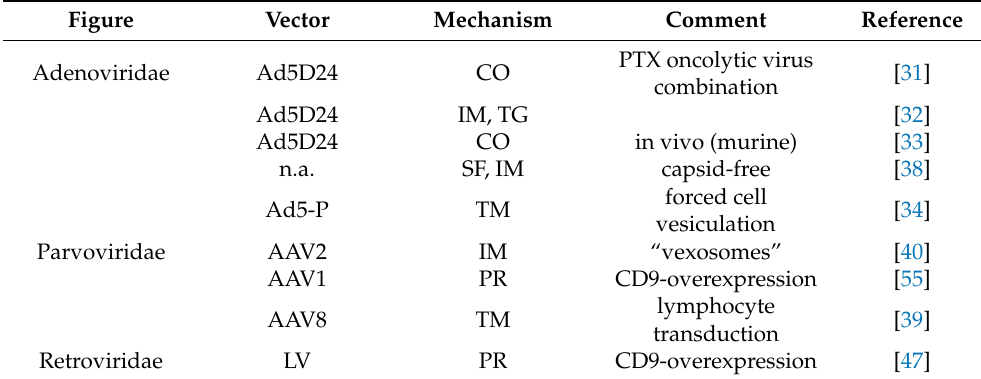
Table 2. Examples for VV-EV interactions. Figure Vector Mechanism Comment Reference PTX oncolytic virus Adenoviridae Ad5D24 CO combination Ad5D24 IM, TG in vivo